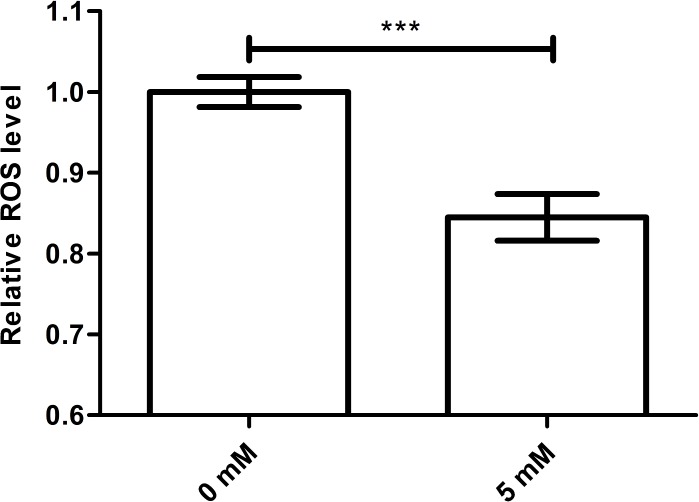
Effect of arbutin on ROS accumulation in C. elegans.Wild type N2 animals treated with 5 mM arbutin accumulated less ROS than wild type N2 control animals. Error bars represented the standard error of the mean (SEM) (N = 24–25 parallel experiments, p < 0.001).